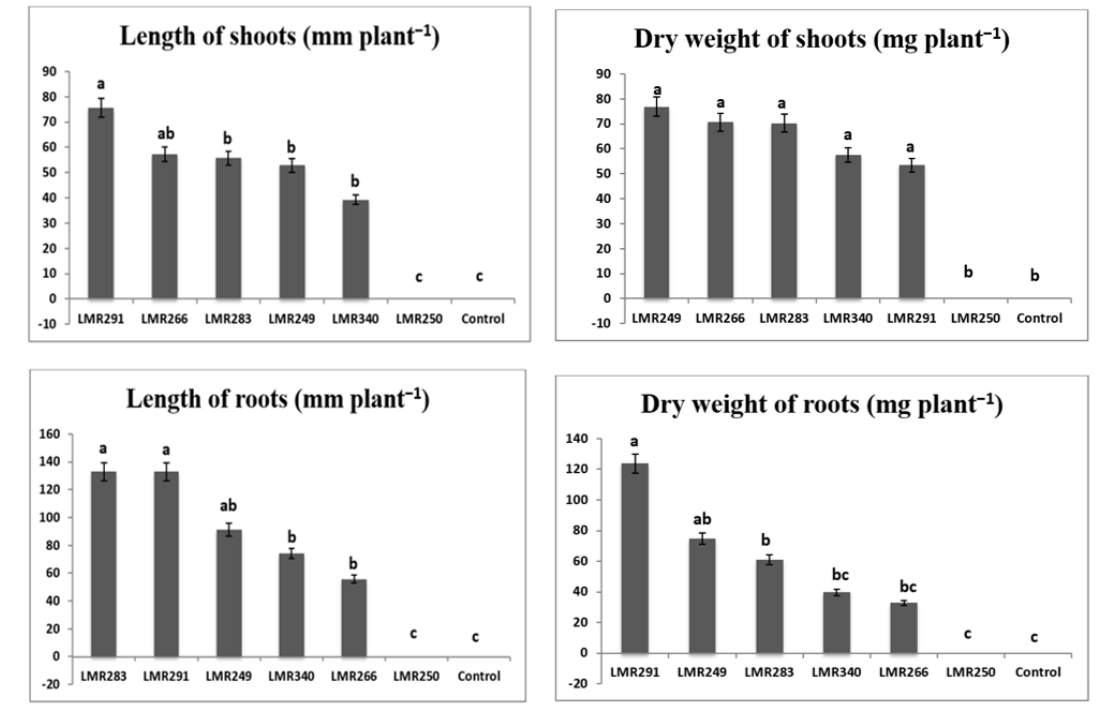
Figure 5. Effect of bacterial inoculation on shoots and roots of Sulla plants growing in heavy metal- contaminated soil. All the values are means of 12 replicates. One-way ANOVA was performed to determine the influence of inoculated bacteria on root and shoot biomass. Means for the different treatments with different letters are significantly different from each other ( p < 0.05) according to Duncan test.